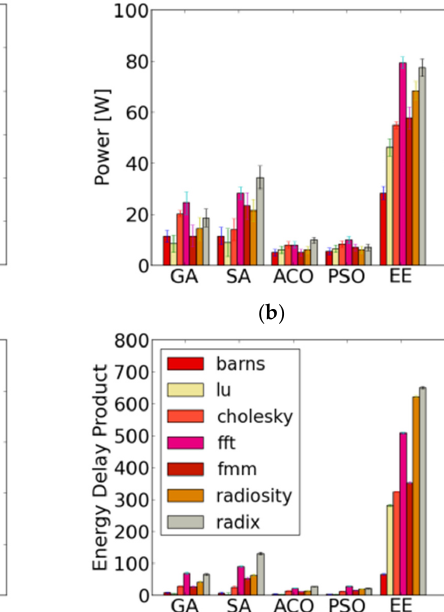
Figure 8. SPLASH-2 [45] benchmarks comparison for 10 × 10 NoC ( a ) throughput, ( b ) power, ( c ) latency and ( d ) energy delay product.